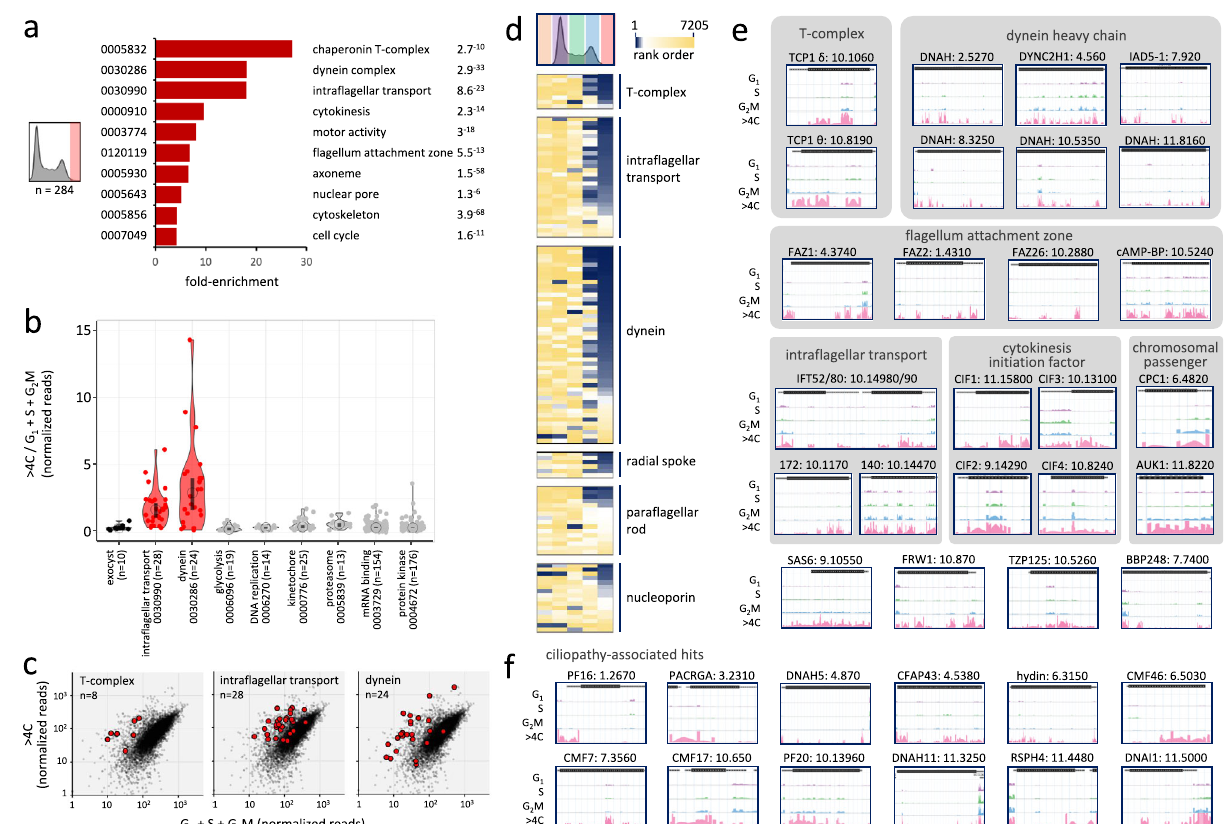
Fig. 3 | Cytokinesis defects associated with endoreduplication. a The bar-graph shows enriched Gene Ontology terms associated with the >4C hits, those that exceed the mean fold-change value in this set by >1.75 times the SD. P -values are shownontheright. b Theviolinplotshowsrelative>4Cread-countsforcohortsof genes and re fl ects data distribution. Open circles indicate median values and the vertical bars indicate 95% con fi dence intervals. Signi fi cantly overrepresented cohorts are indicated in red. c The plots show overrepresentation of T-complex,